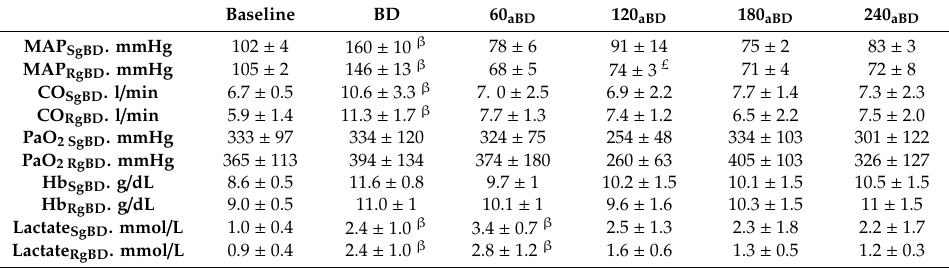
Table 1. Hemodynamic parameters evolution of SgBD and RgBD groups, before brain death (Baseline), at brain death (BD) and during 240 min of porcine management after brain death (aBD). Baseline BD 60 aBD 120